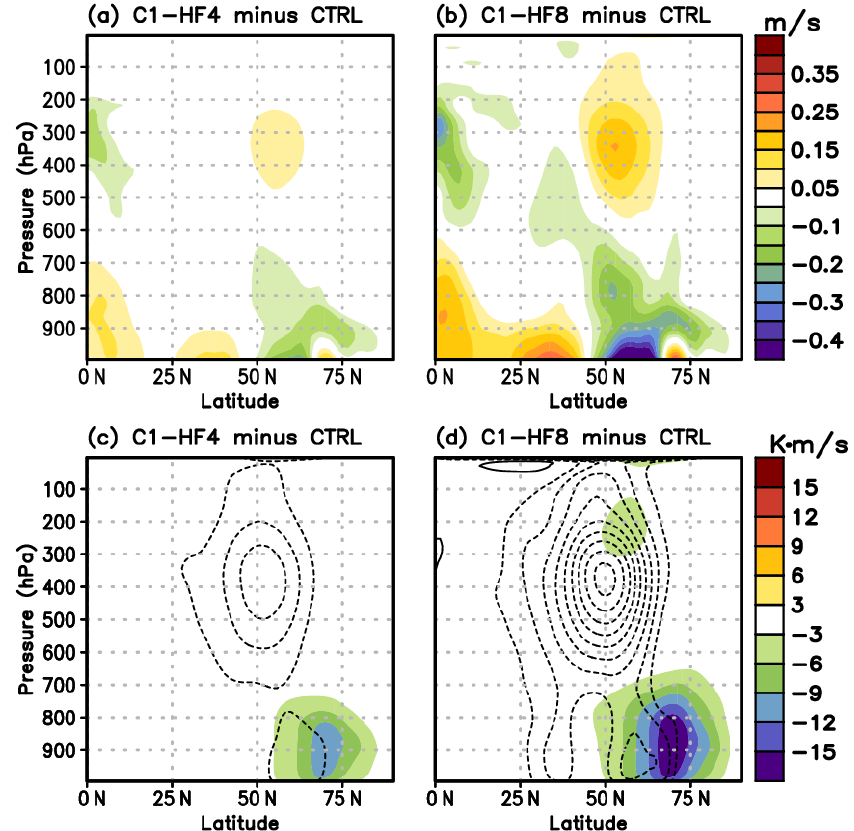
Figure 3. Time-mean zonally averaged ( a , b ) meridional wind deviation (shaded) from control experiment, ( c , d ) transient eddy momentum flux deviation (contours) and transient eddy heat flux deviation (shaded) from control experiment; contour intervals are 2 m 2 /s 2 .